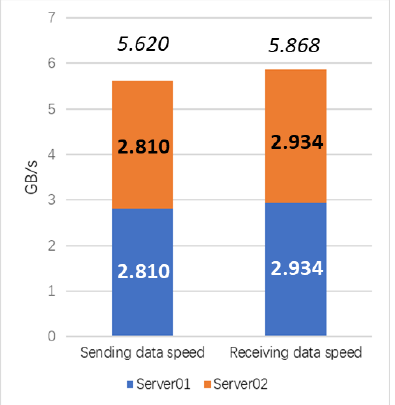
Fig. 3. Maximum transferring data